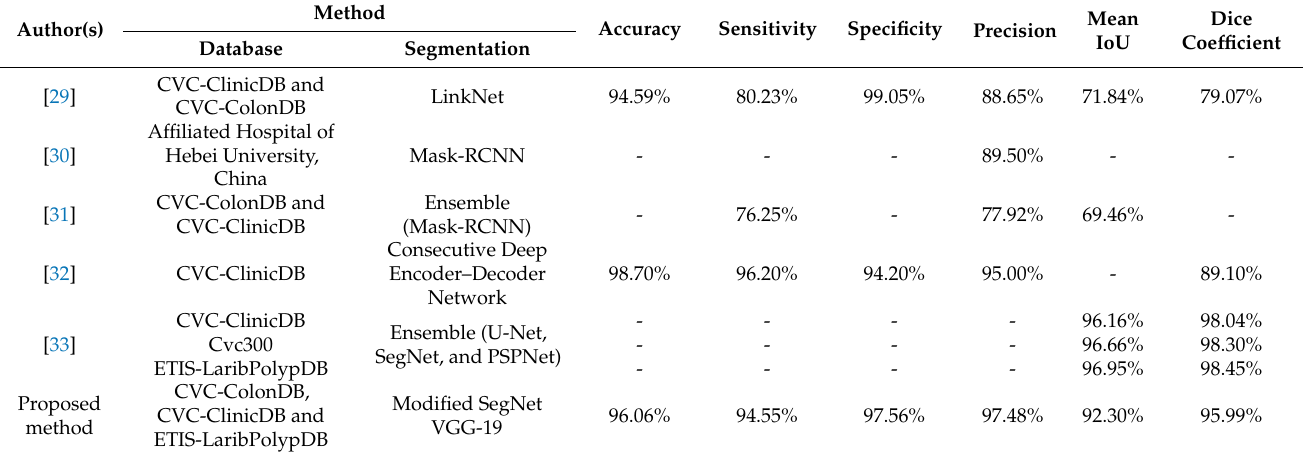
Table 6. Comparison of our model with other recent convolutional neural network (CNN)-based